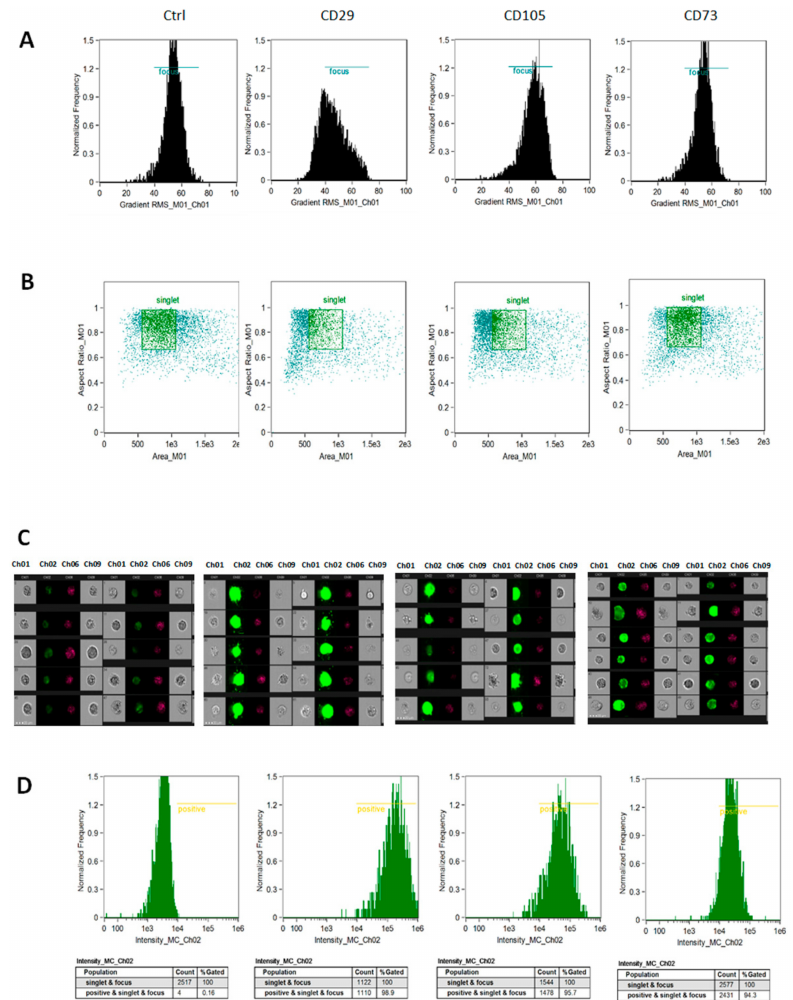
Figure 2. Strategy of flow cytometric analysis for hAMSC phenotypic markers. Cells in best focus, i.e., those with higher Gradient root mean square (RMS) values, were identified ( A ) to draw brightfield scatter plots, ( B ) obtained by plotting Area vs. Aspect Ratio, to identify single cells events (identified by a square region). In ( C ), ten cells for condition are shown, five on the first four columns and five more on the last four columns, as di ff erent channels: Ch01 and Ch09 (brightfield); Ch02 (FITC fluorescence); Ch06(sidescatter). TheintensityofCh02vs. normalizedfrequency( D )wasusedtocalculatethestatistics Count and Percent Gated on 10,000 single-cell events for sample. Ctrl = cells incubated in the absence of antibody. The analysis for p2 hAMSCs of Group 1 is depicted. FITC: fluorescein